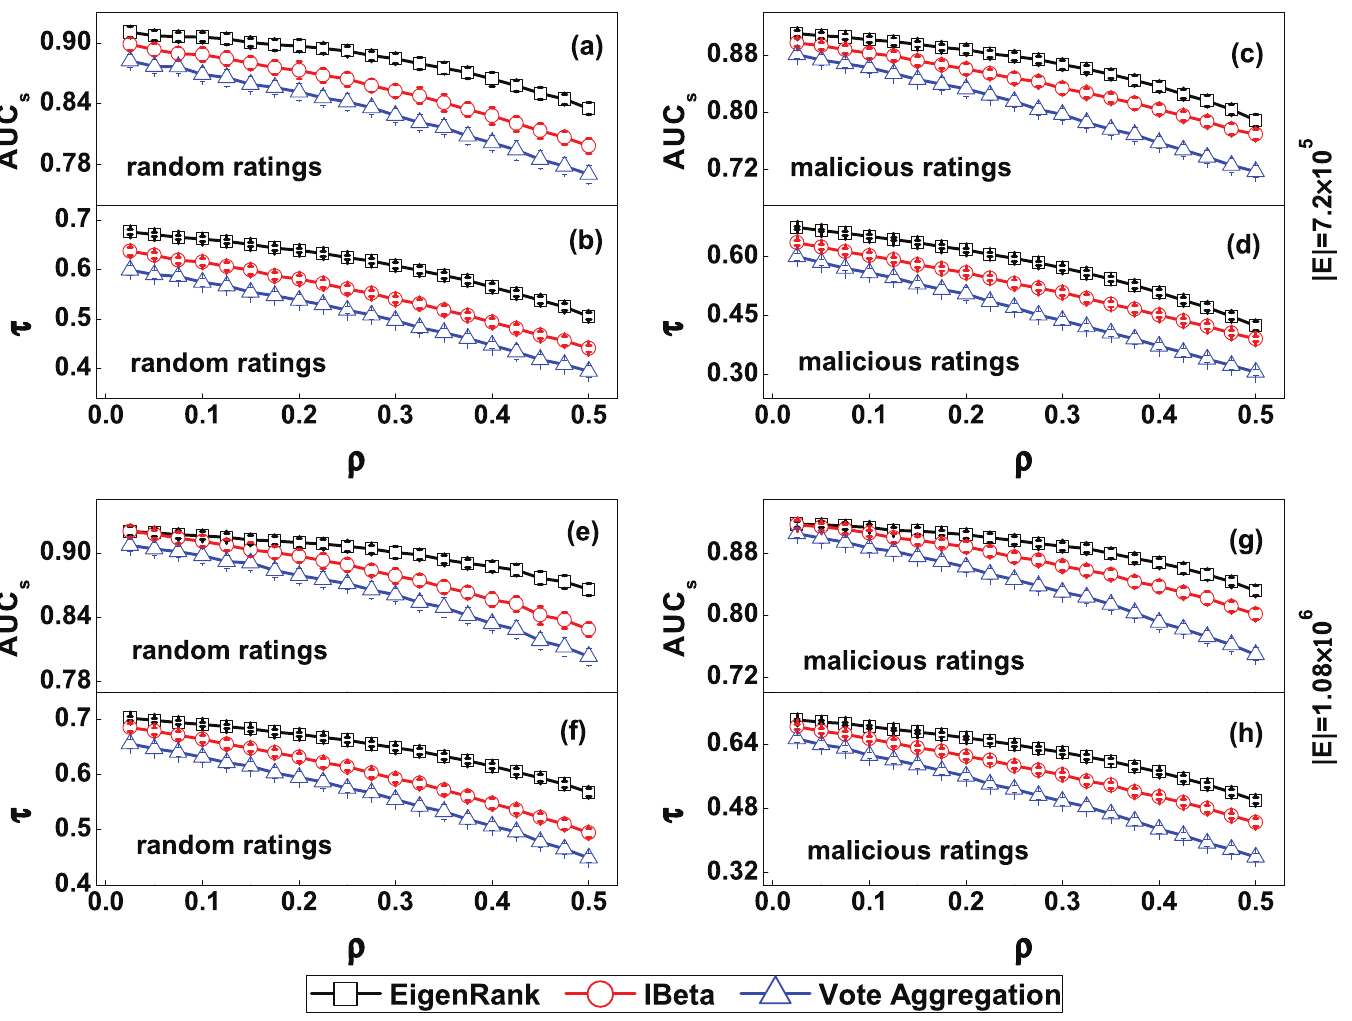
Fig 1. (Color online) AUC and τ of the EigenRank algorithm, IBeta method and Vote Aggregation method for the synthetic networks: (a, b) in the random rating s attack case when | E | = 7.2 × 10 5 ; (c, d) in the malicious rating attack case when | E | = 7.2 × 10 5 ; (e, f) in the random rating attack case when | E | = 1.08 × 10 6 ; (g, h) in the malicious rating attack case when | E | = 1.08 × 10 6 . The parameter ρ denotes the ratio of random/malicious ratings. It can be seen that both the AUC EigenRank algorithm exceed their counterparts in the IBeta method and Vote Aggregation method with different ρ and | E |. The results are averaged over 50 independent realizations. The error bars are the corresponding standard